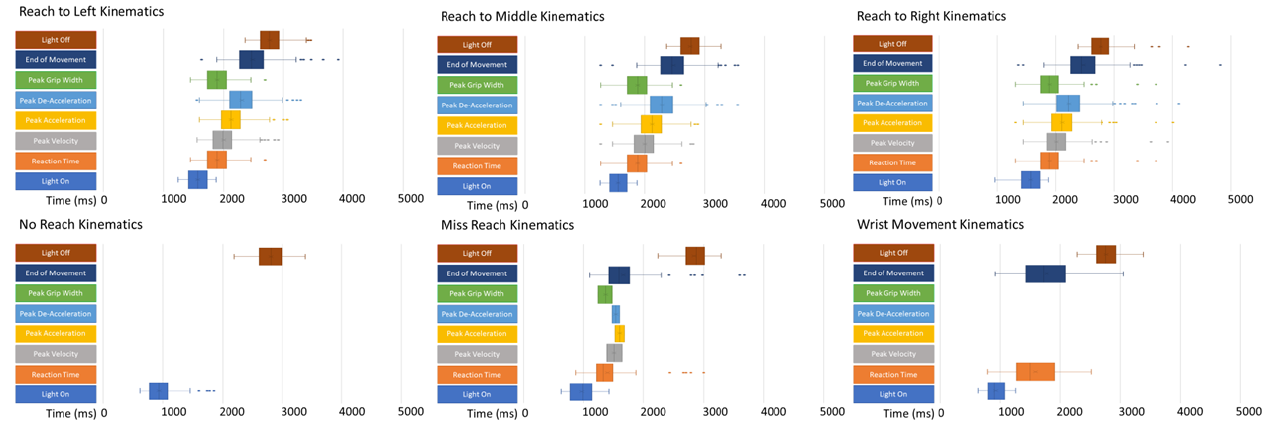
Figure 6. A box and whisker plot displaying the timelines of key kinematic variables averaged across trials, including mean, standard deviations and range of light on, reaction time, peak acceleration, peak velocity, peak deacceleration, maximum grip width, movement end and light off. Top row includes timeline for reach to left object, reach to middle object and reach to right object. Bottom row includes no reach, miss reach and wrist movement.